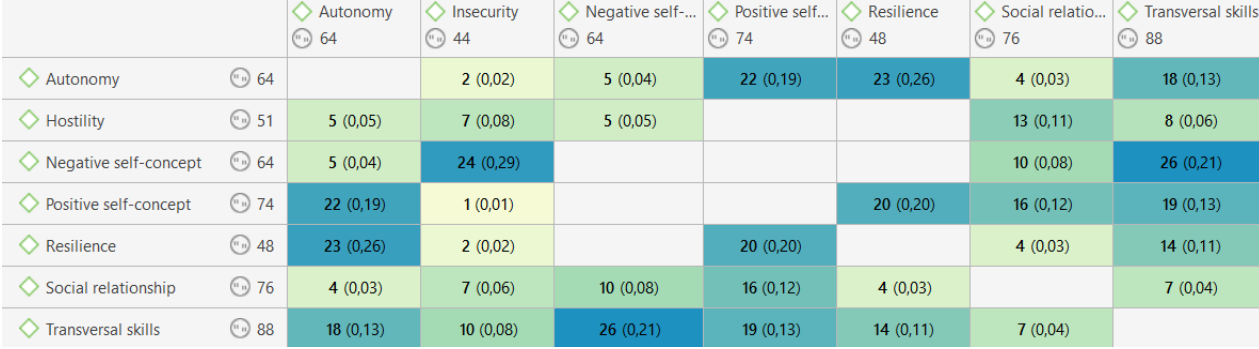
Figure 4. Analysis of relationships by code co-occurrence.